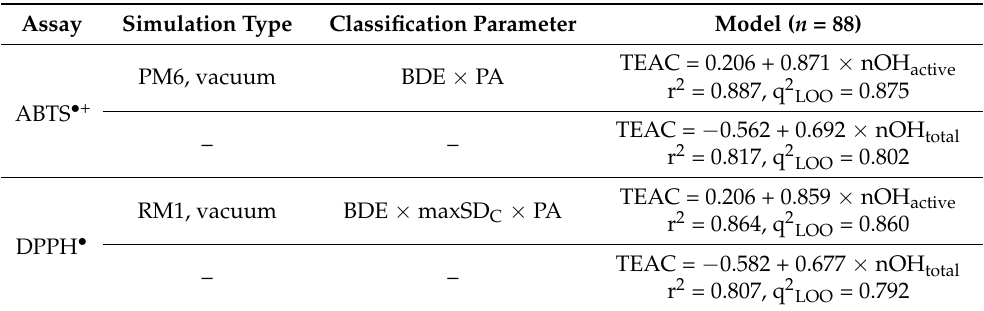
Table 2. Models with the highest internal predictive ability obtained for ABTS • + and DPPH • assays, compared to those obtained without OH-group classification. For q 2 LOO calculations, all thresholds were recalculated for each LOO